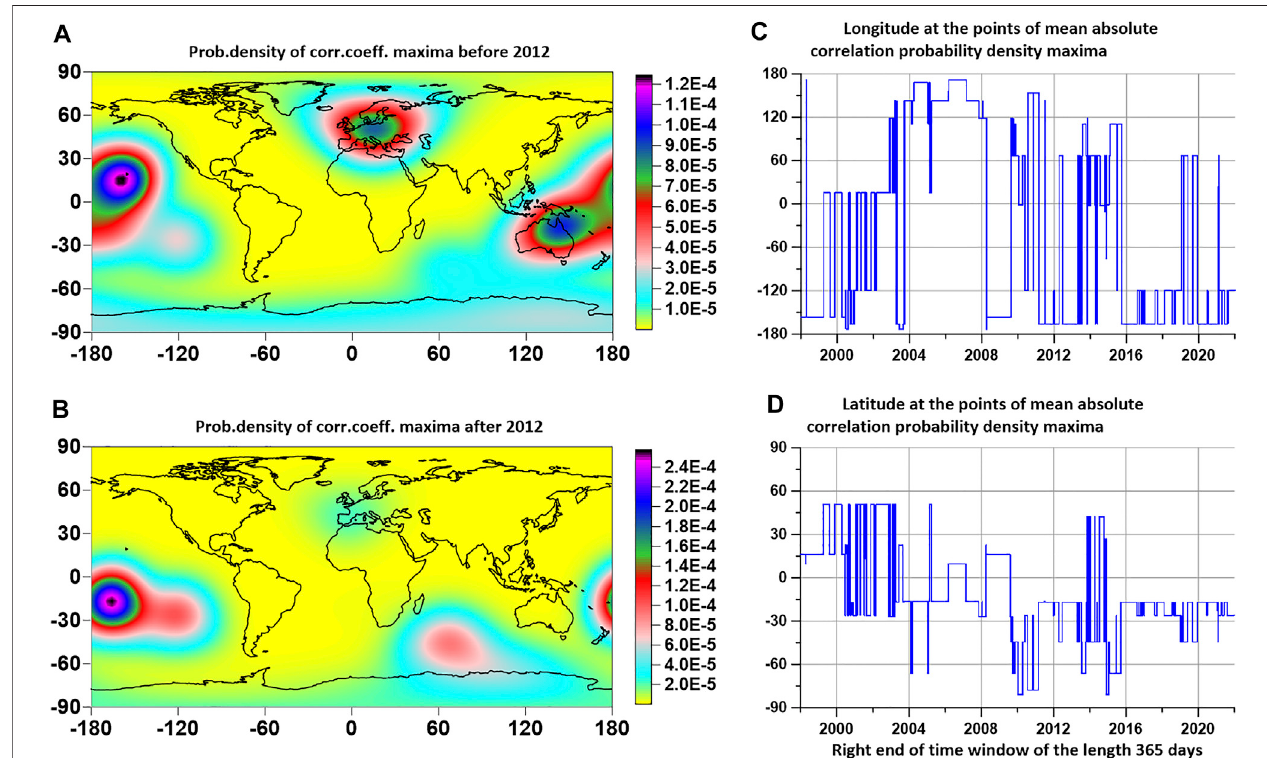
FIGURE 6 | (A,B) are maps of probability density distributions of the maxima of the average values of the modules of pairwise correlation coef fi cients between the values of seismic noise properties γ , Δα and En at each reference point in a sliding time window 365 days long for the timestamps of the right end of the window before and after 2012. (C,D) are plots of longitude and latitude of points of maximum probability densities of maximum values of average absolute correlations of noise properties.